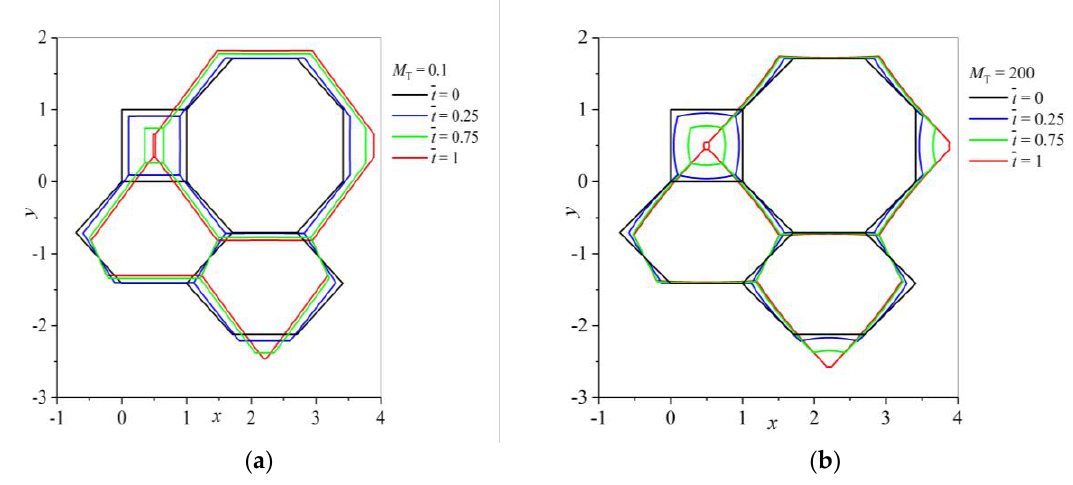
Figure 2. Evolution of the grain arrangement for different normalized times t . ( a ) All mobilities M T i are set to the small value 0.1. ( b ) All mobilities M T i are set to a large value 200, so that the kinetics is curvature-driven only.